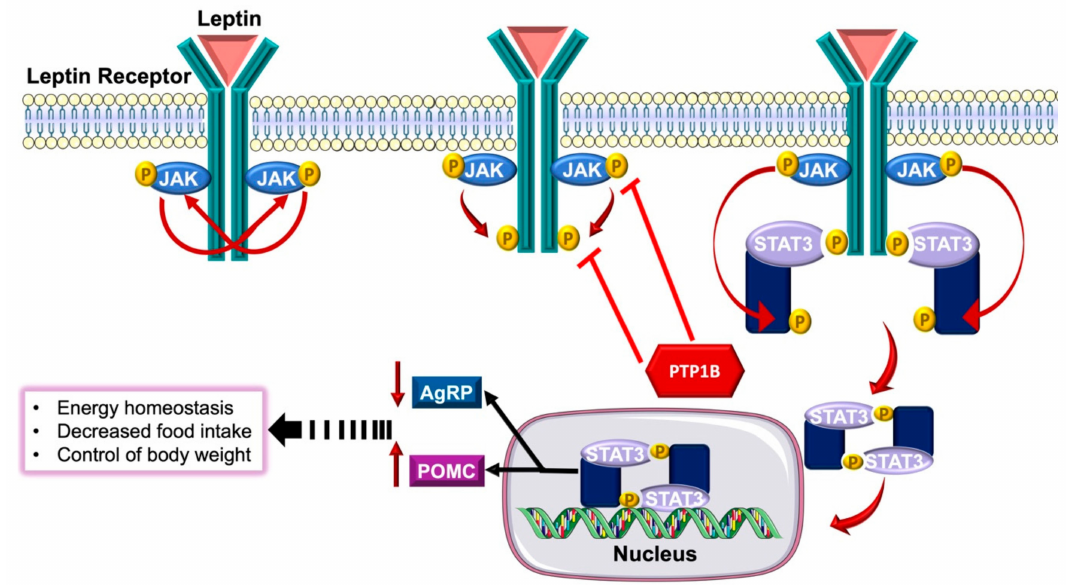
Figure 4. Leptin signaling. Binding of leptin results in the cross-linking of two adjacent receptors and the recruitment of Janus Kinase 2 (JAK2), which cross-phosphorylates each other. Activated JAKs phosphorylate tyrosine residues on the receptor allowing the docking of signal transducer and activator of transcription 3 (STAT3). JAKs phosphorylate STAT3, which then dissociate and dimerize. STAT3 dimers translocate to the nucleus where they upregulate the expression of anorexigenic protein pro-opiomelanocortin (POMC) and suppressing that of the orexigenic protein Agouti-related peptide (AgRP) mediating the regulation of energy expenditure, control of body weight and suppresses appetite. The negative regulatory actions of PTP1B on leptin signaling pathway are